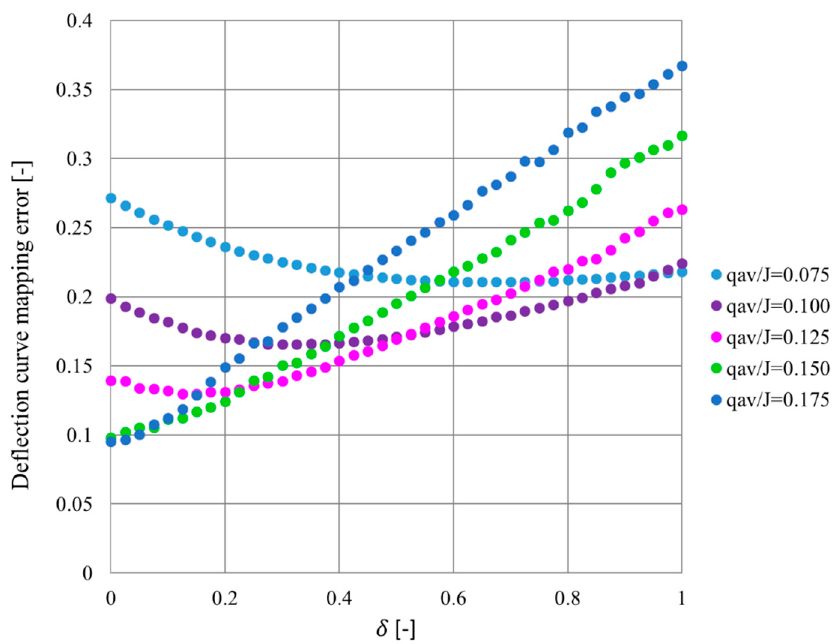
Figure 11. Deflection curve mapping error of the C_L test curve as a function of parameter δ ( k = 0) for di ff erent values of the q av / q J ratio.